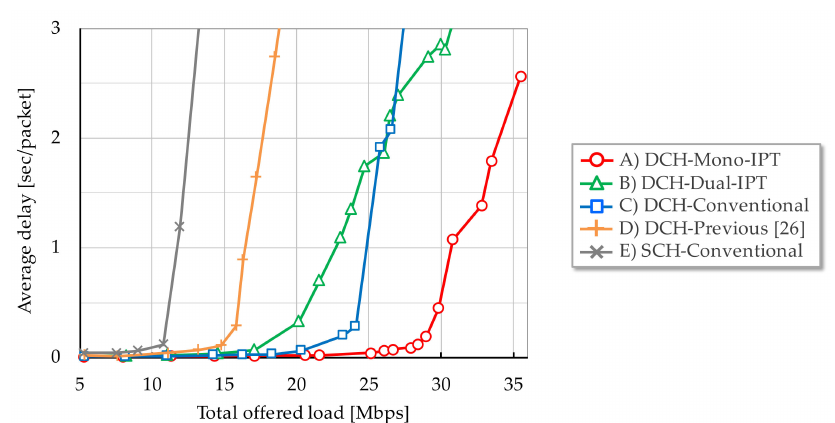
Figure 6. System throughput.